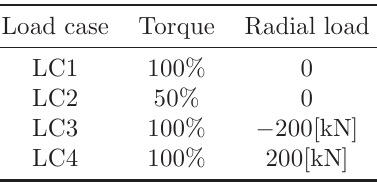
Figure 3: Definition coordinate systems and